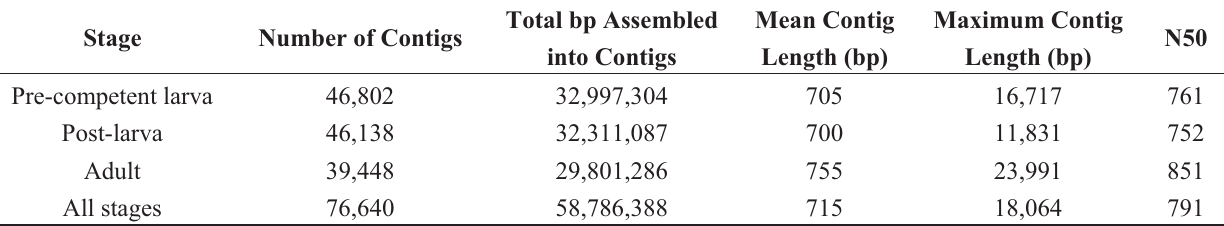
Table 2. Summary statistics for the assemblies of the trimmed